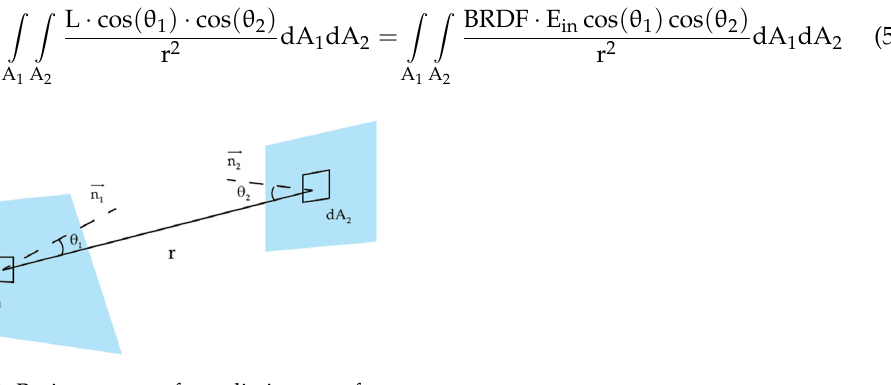
Figure 2. Basic geometry for radiation transfer.